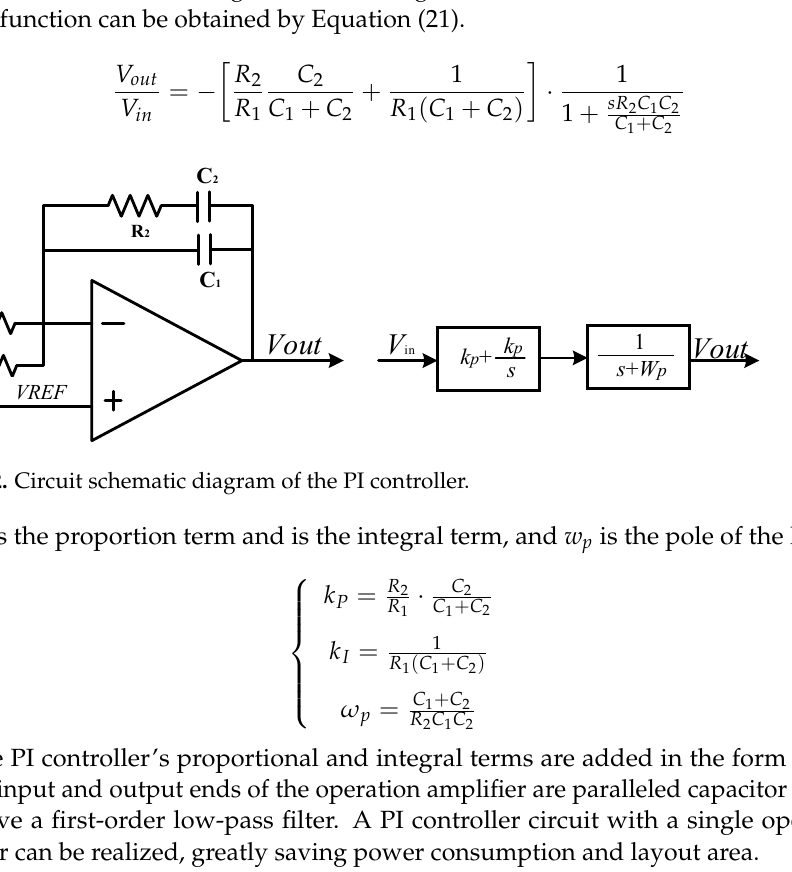
V cm V in- Figure 13. The transistor-level circuit structure diagram of nonlinear multiplier. First, V cm is set so that transistor M 1 works in the linear region. Transistors M 5 and M 1 and resistor R 1 form a common source amplifier with negative feedback from the P-type